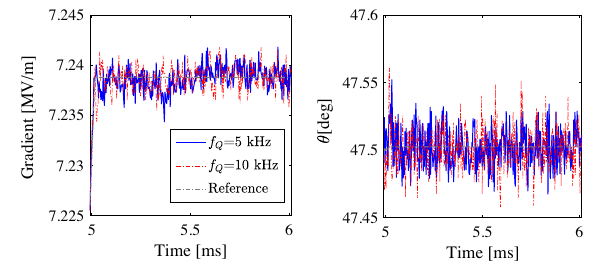
FIG. 23. Amplitude and phase stabilities during the flat top of the pulse rf in the case of P þ DOB control on ML2 at 7.5 MV in terms of different f Q .